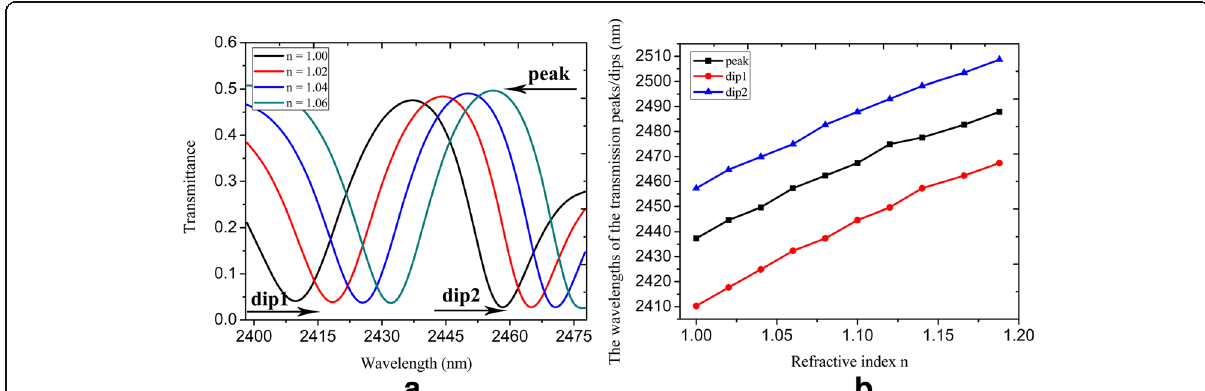
Fig. 6 a The spectral transmittance with refractive index n = 1, 1.02, 1.04, and 1.06; b the peak/dip wavelengths of the spectral transmittance versus the refractive index n . The parameters are set as W = 800 nm, L = 620 nm, d = 20 nm, W U = 150 nm, L U = 120 nm, L 1 = 220 nm, L 2 = 250 nm, L